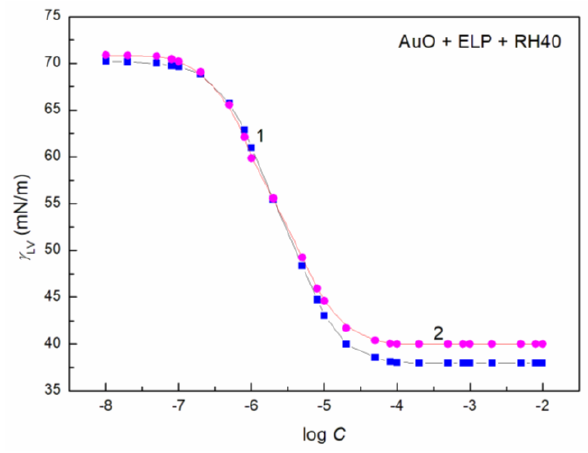
Figure 4. A plot of the surface tension ( γ LV ) of aqueous solutions of ELP + RH40 (mole fraction of ELP in the bulk phase, α , equal to 0.8) (curve 1, squares) and AuO + ELP + RH40 ( α = 0.8) mixtures (curve 2, circles) vs. the logarithm of ELP + RH40 concentration (log C ).